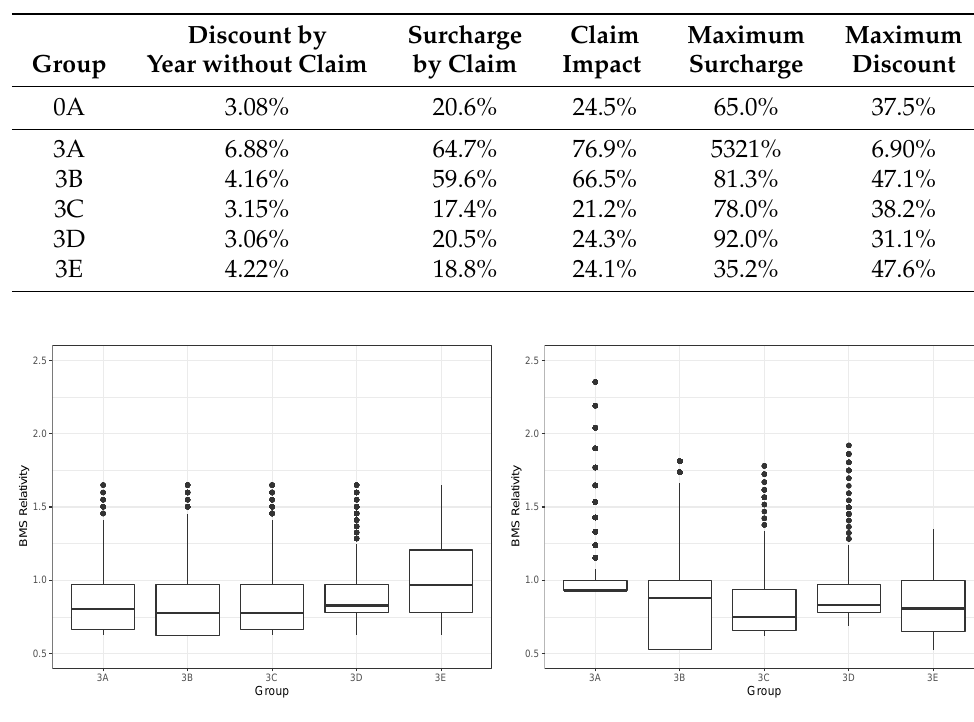
Figure 7. Distribution of the BMS relativities for each group ( left : original BMS, right : BMS by group). Table 7. Estimated parameters for BMS models applied to each